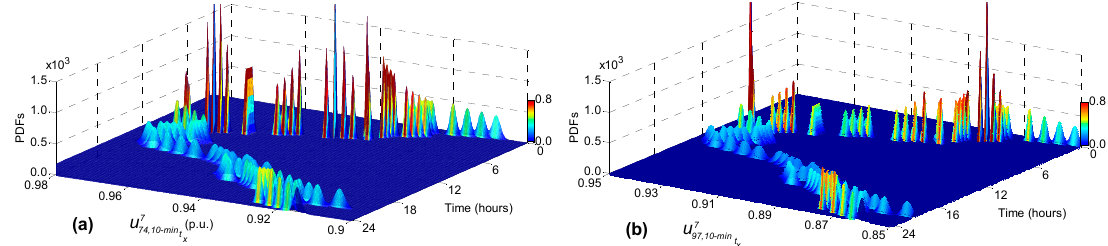
Figure 9. PDFs of the 10-min voltage magnitude at node 97 in different scenarios. ( a ) around 00:00 h; ( b ) around 08:00 h.